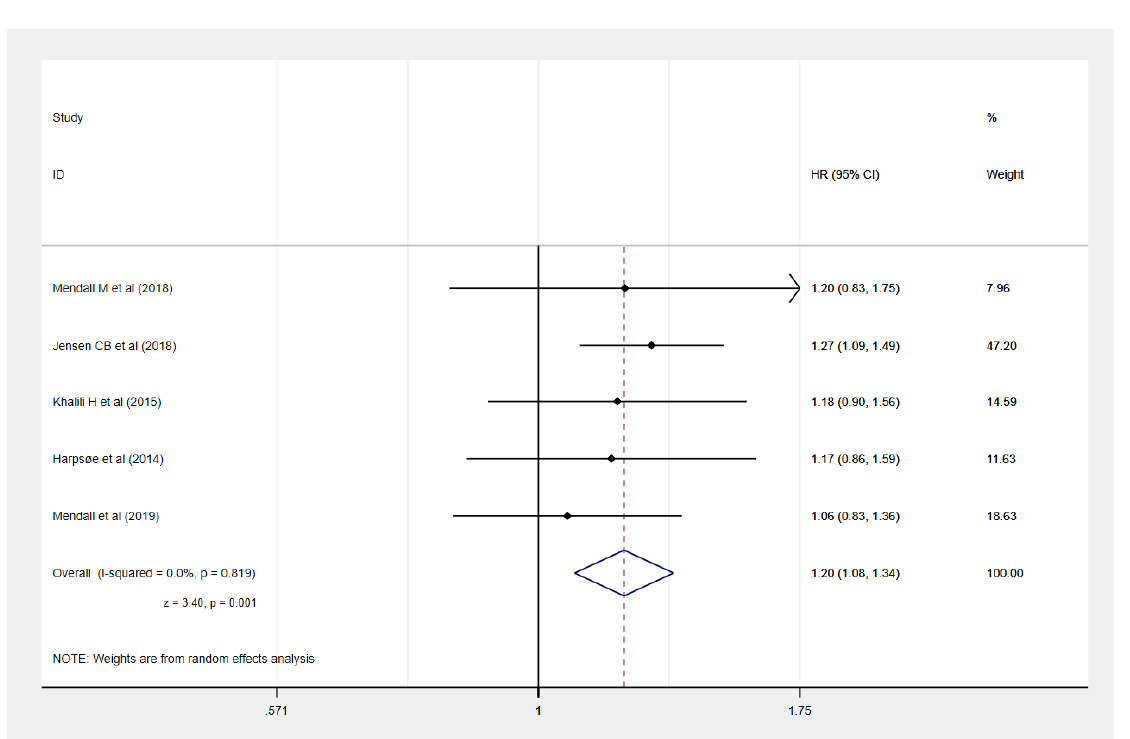
Table 1. Core characteristics of studies included in the meta-analysis [9–17,20] .